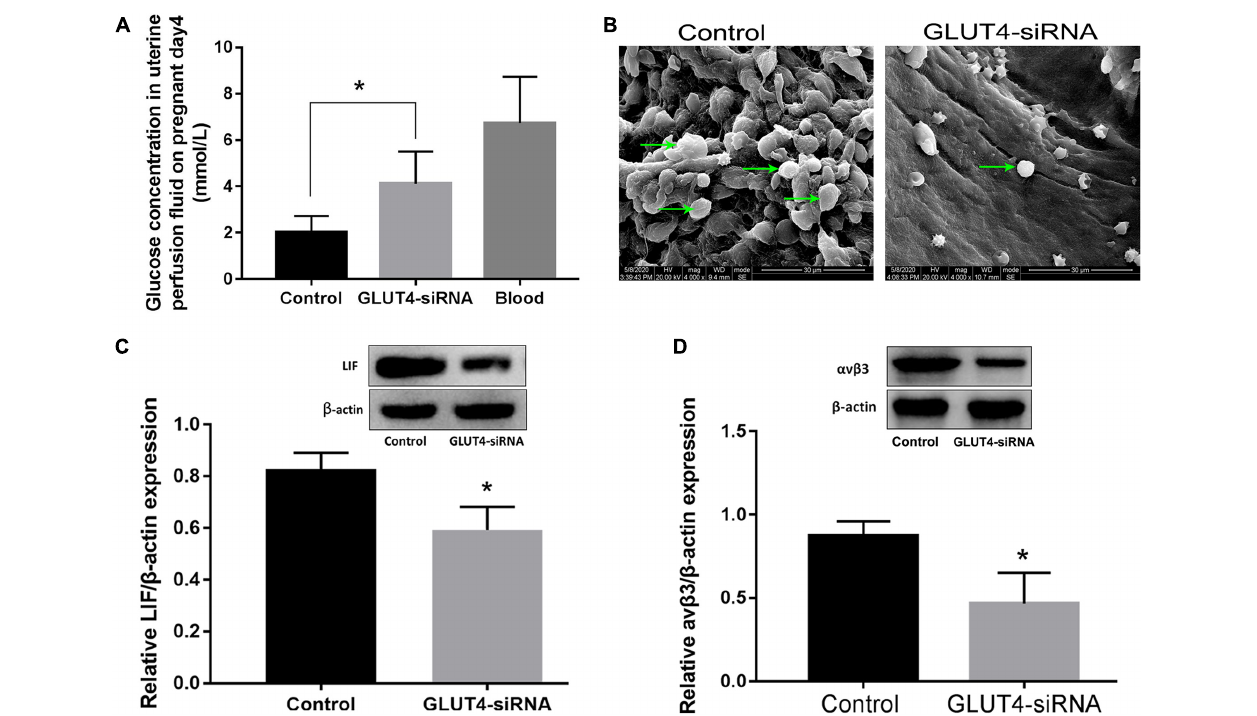
FIGURE 4 | Effect of GLUT4 on glucose concentration in the uterine fluid and endometrial receptivity following GLUT4-siRNA transfection. (A) Uterine fluid was collected on pregnant day 4 using in vivo uterine perfusion and glucose concentration in the uterine fluid was measured by HPLC. The glucose concentration in the GLUT4-siRNA side was obviously higher than that in the control side (4.12 ± 0.57 vs. 2.01 ± 0.29 mM, ∗ P < 0.05 vs. control, n = 12), but was still lower than that in blood (6.7 ± 0.72 mM). (B) Pinopode formation in the luminal epithelium was observed by SEM on pregnant day 4. Arrows indicate pinopodes. Scale bar , 30 µ m. (C) Western blotting analysis for leukemia inhibitory factor (LIF) expression on pregnant day 4 following GLUT4-siRNA transfection. Relative density analysis of the LIF protein by Image Lab 3.0 software ( n = 3, normalized by β -actin). (D) Western blotting for integrin ανβ 3 expression following GLUT4-siRNA transfection ( n = 3, normalized by β -actin). * P < 0.05 vs.